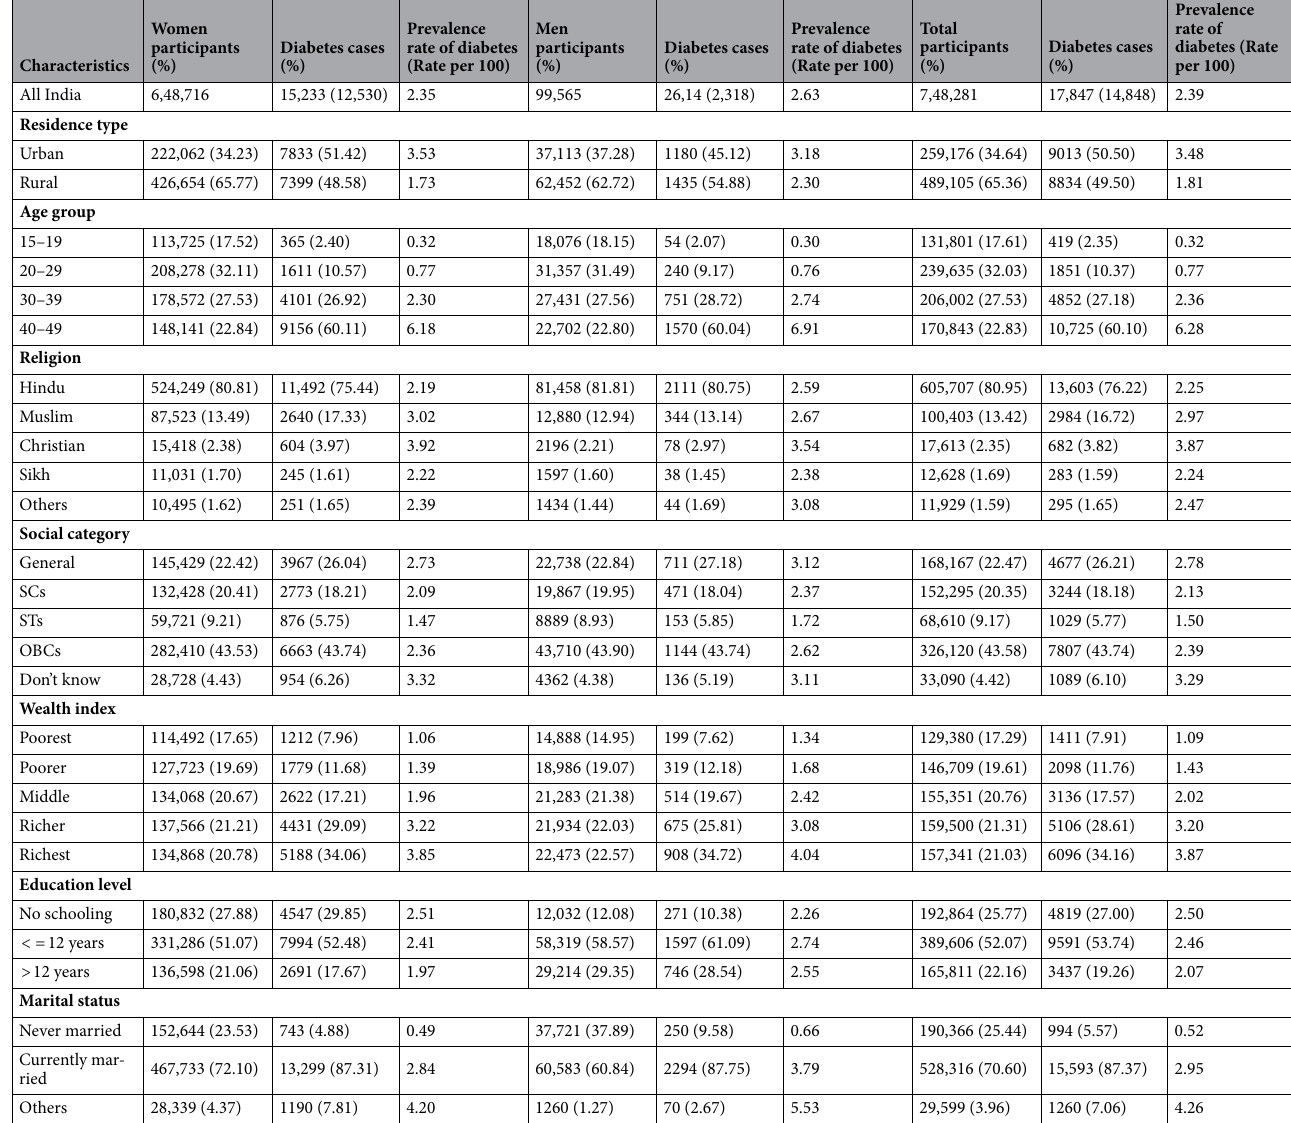
Table 1. Sample distribution and prevalence of diabetes among different socioeconomic and demographic groups in women and men of age group 15–49 years in National Family Health Survey, 2015–2016. All the values are weighted using sample survey weights from NFHS-4 and values in the parenthesis at all India level are